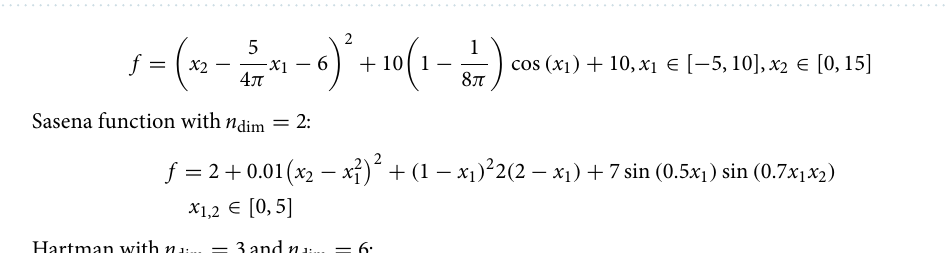
Figure 3. MPI, PPI and DPI algorithm on Forrester function compared with the standard EI